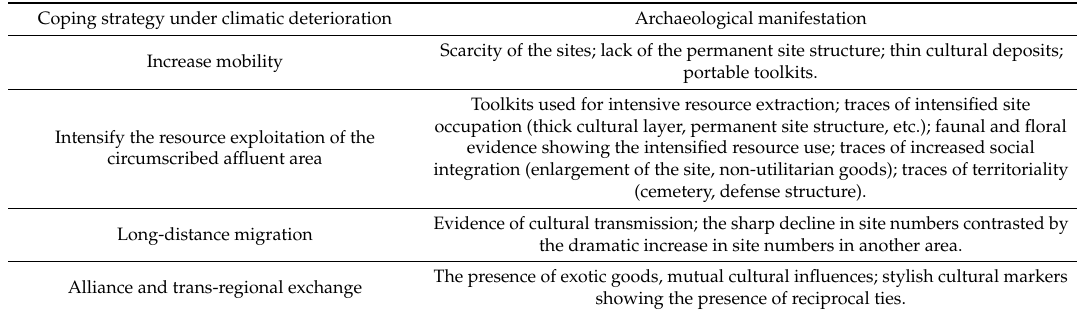
Table 1. Di ff erent coping strategies under climatic deterioration and their corresponding material implications reflected by archaeological